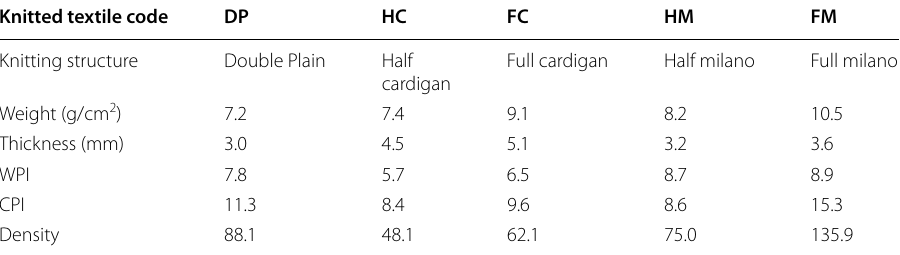
Density DP, double plain (DP); HC, half cardigan; FC, full cardigan; HM, half Milano; FM, full Milano; WPI, Wales per inch; CPI, Courses per inch; Density, Wales per inch x Courses per inch